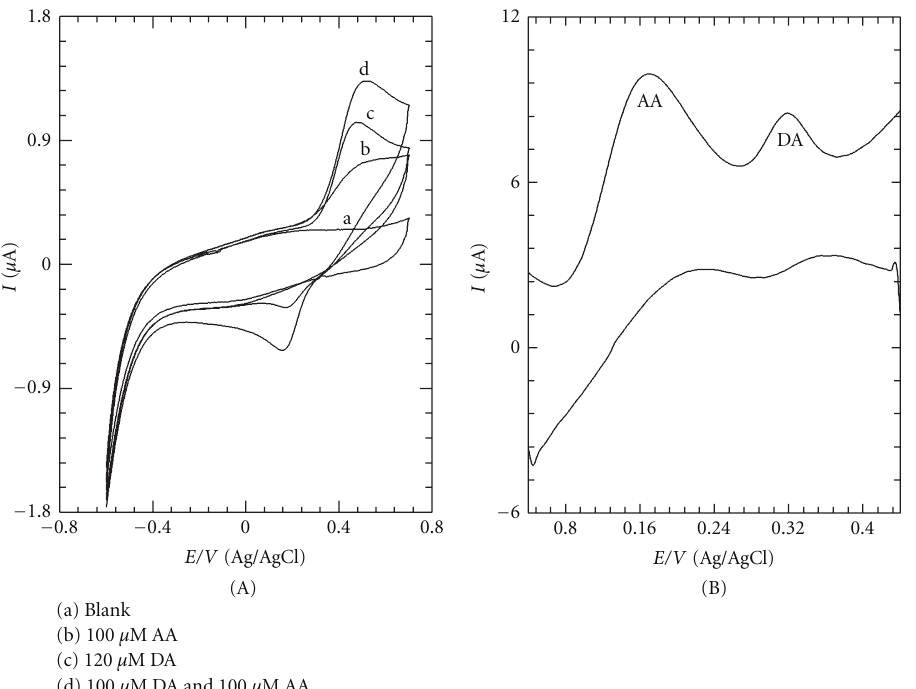
Figure 7: Cyclic voltammograms obtained on (A) the bare GCE in di ff erent solutions, blank (curve a), 100 μ M AA (curve b), 120 μ M DA (curve c), and in a mixture solution of 100 μ M AA and 100 μ M DA (curve d) and (B) GC/RuOHCF/RuHCF electrode in a mixture solution of 1.5mM AA and 50 μ M DA. pH 5, scan rate: 100 mV/s.